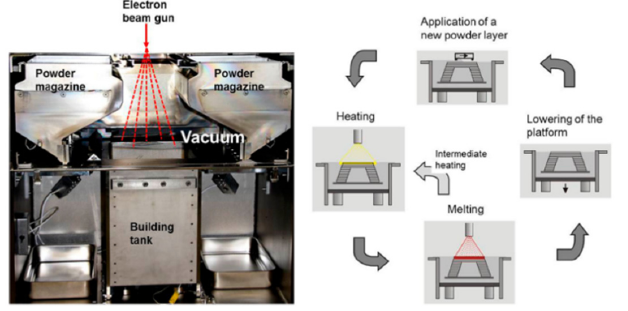
Figure 3. The SEBM process. Left: Process chamber. Right: 4 ‐ step process for building one layer. Adapted from [25], Maney Publishing, 2016.